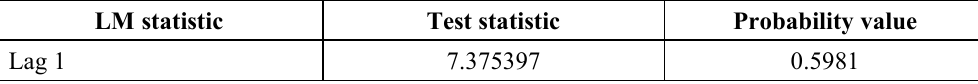
Table 9 . Residual Serial Correlation LM Tests